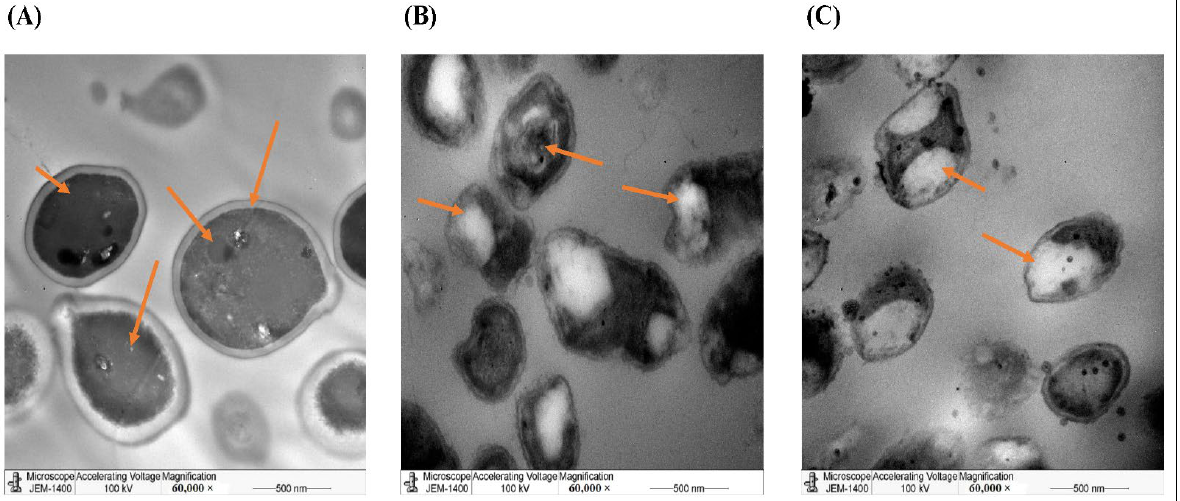
Figure 5. TEM imaging of C. albicans showing the morphological changes with different treatments . C. albicans cells were either ( A ) non-treated (Control), ( B ) treated with AgNPs of the aqueous extract (10 mg/mL), or ( C ) treated with AgNPs of the ethanolic extract (10 mg/mL). Arrows indicated some morphological differences.